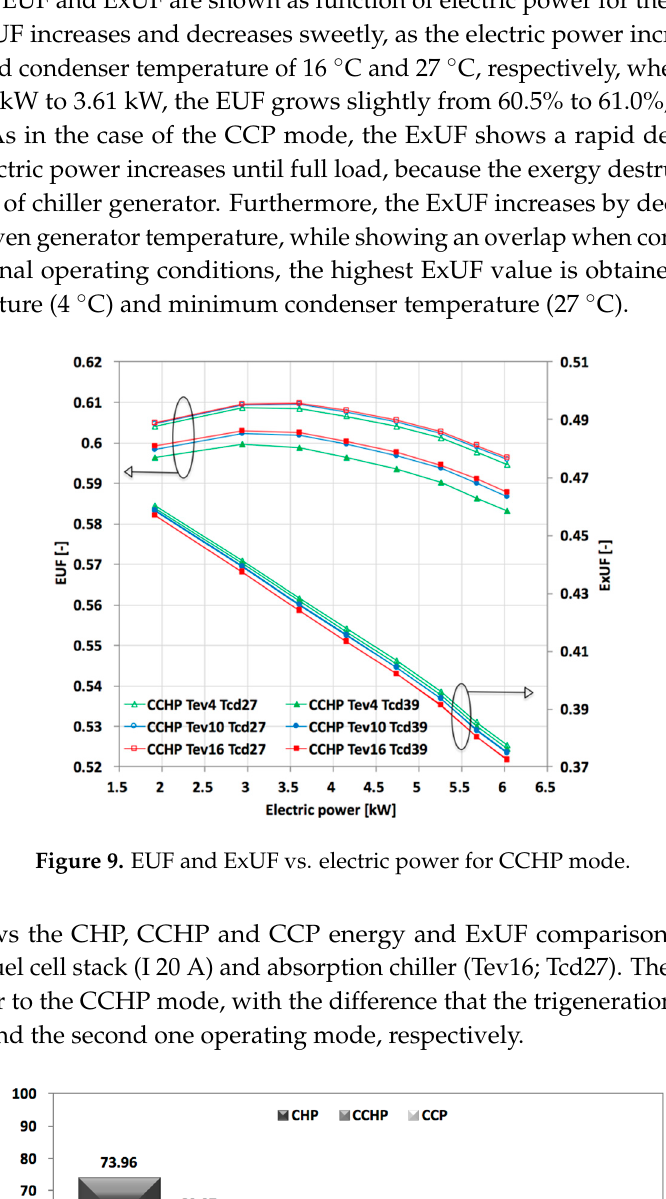
Figure 8. EUF and ExUF vs. electric power for CCP mode.